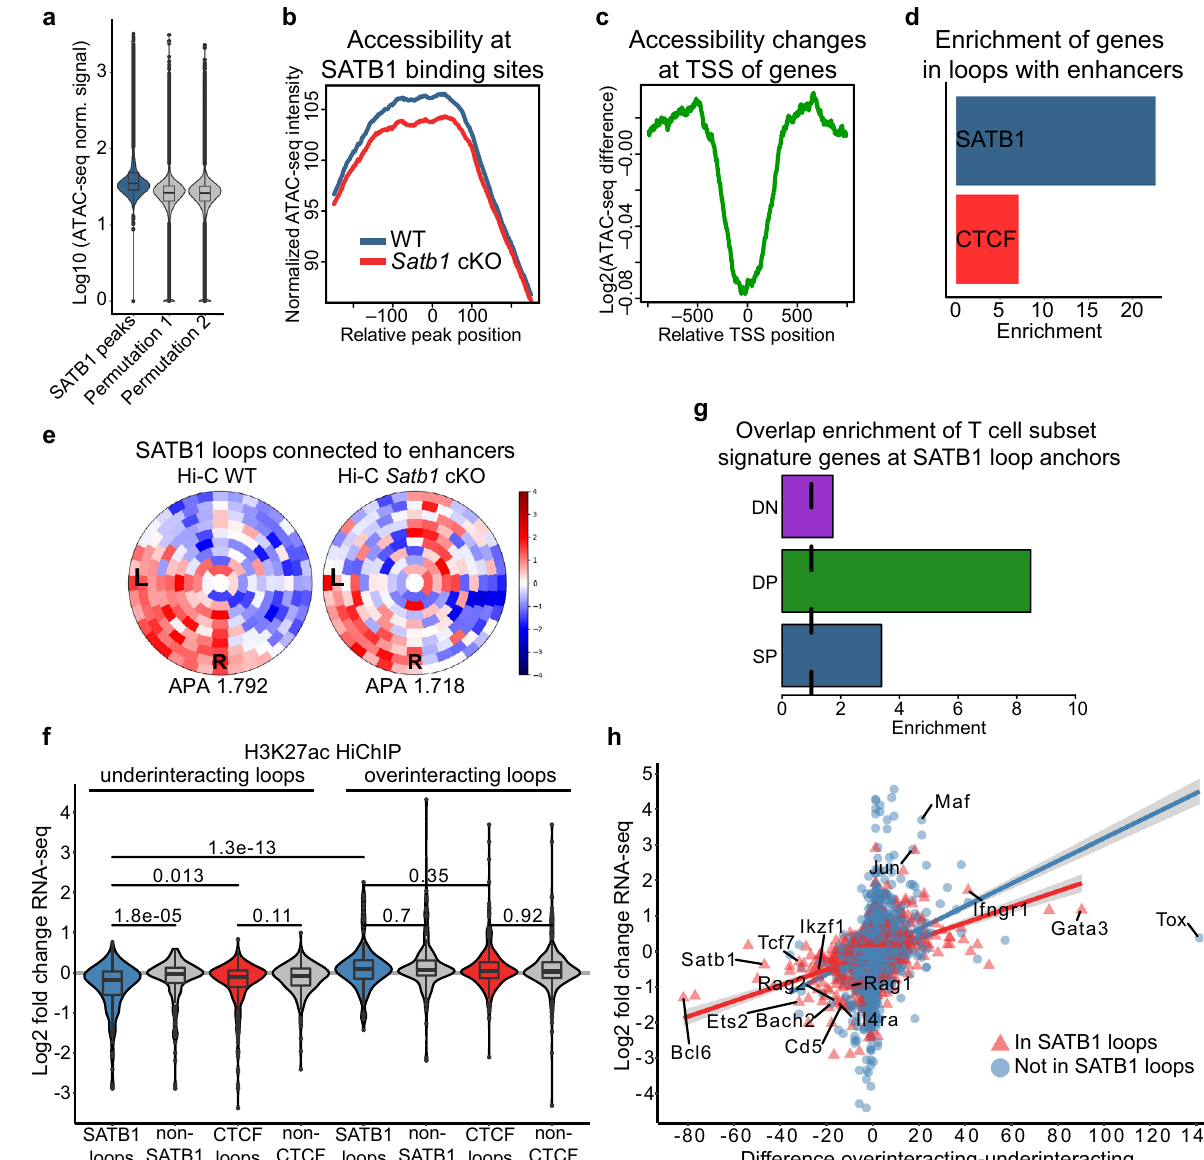
Fig. 4 | SATB1-dependent promoter-enhancer communication of critical immune-relatedgenes.a ATAC-seqsignalindicateshigherchromatinaccessibility at WT SATB1 binding sites than expected by chance (i.e, randomly shuf fl ed SATB1 bindingsites).100randomizationswereusedforstatisticalevaluation(p-value~0). Two representative random distributions are depicted in the fi gure. b Chromatin accessibilityatSATB1bindingsitesisdecreasedin Satb1 cKO. c Log2foldchangeof chromatin accessibility indicates the highest accessibility drop in Satb1 cKO being at the TSS of genes. d SATB1-dependent loops connecting genes to enhancers are about three-fold enriched compared to CTCF loops. e SATB1-dependent loops connected to enhancers display enriched interaction signal between left (L) and right (R) anchor in WT Hi-C data (z-score normalized), which is deregulated in the Satb1 cKO. Aggregate peak analysis (APA) 1 was calculated and visualized by SIPMeta 61 . See also Supplementary Fig. 4g for more details. f Log2 fold change expression values of genes that were present in anchors of H3K27ac HiChIP loops under- and over-interacting in Satb1 cKO and which also did or did not intersect with SATB1/CTCF-dependent loops. An equal number of underinteracting loops